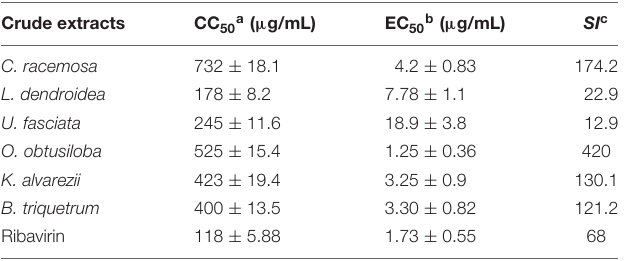
TABLE 1 | Cytotoxicity (CC 50 ) in Vero Cells, anti-CHIKV profile (EC 50 ) and selectivity index (SI) of crude extracts from six seaweeds and ribavirin. Crude extracts CC 50a ( µ g/mL) EC 50b ( µ g/mL) SI c